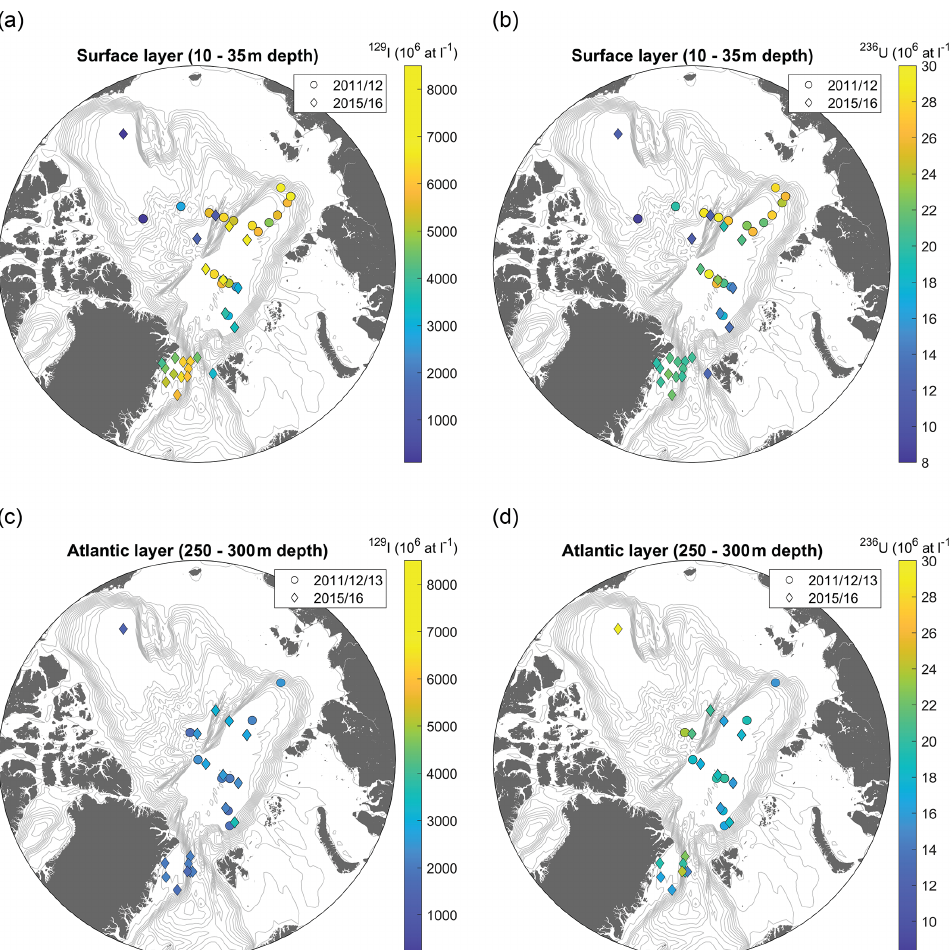
Figure 3. 129 I ( a and c ) and 236 U ( b and d ) concentrations for stations in the Arctic Ocean and Fram Strait used in this study. Results are divided in the surface ( a and b ) and the Atlantic layer (represented here by 250–300m depth) ( c and d ). Different symbols refer to different years, 2011/12/13 in circles and 2015/16 in diamonds. Each data point represents a single measurement (individual station and depth). Note that the same color scale was applied for surface and Atlantic layer for better comparability between both layers. For the measured 129 I and 236 U concentrations, please refer to Table S1 in the